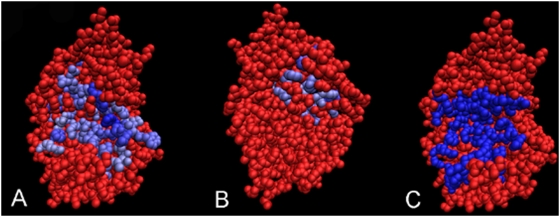
Clustering based on surface atoms.Structure of the catalytic subunit of cAMP-dependent protein kinase (PDB
file 1apm). The experimental interaction site is colored blue in (C).
Clustering based on surface residues detects one conserved cluster that
gives rise to two non-contiguous surface patches. One of them (A)
corresponds to the actual interface and the other (B), which is
positioned opposite to (A), does not. Clustering based on surface atoms
distinguishes the two patches and considers only one of them (A) as a
cluster seed.